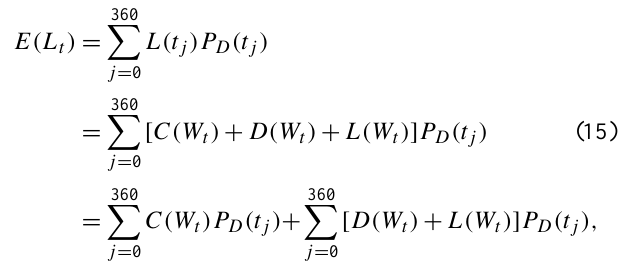
Fig. 15. The probability of dam-break flood in Beichuan as a discrete time series at an interval of one hour in stage 1 (with a breach formation time of three days)